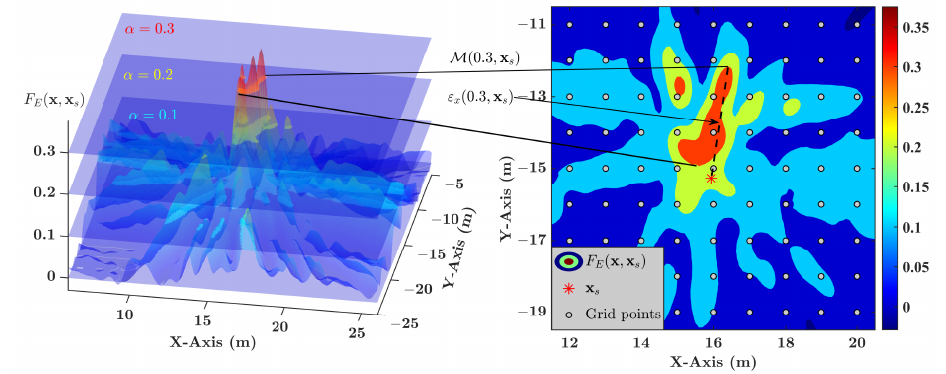
Figure 2. Illustration of the level-pass area M ( α , x s ) . (Orange: M ( 0.3, x s ) ; yellow green: M ( 0.2, x s ) ; celeste: M ( 0.1, x s )